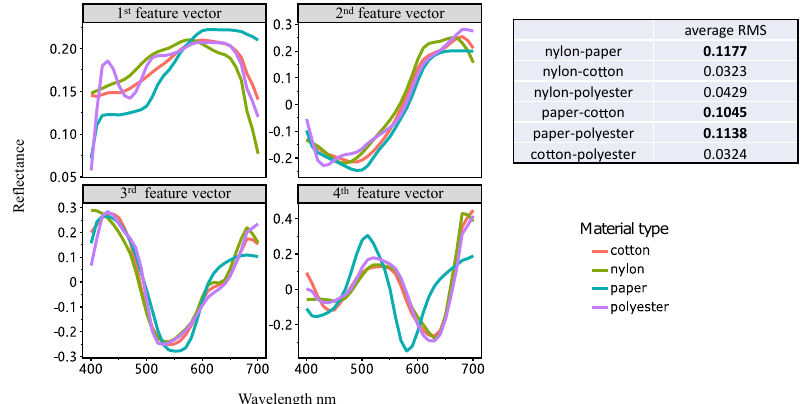
Figure 9. The first 4 feature vectors of 4 kinds of samples (cotton, polyester, nylon, and paper).